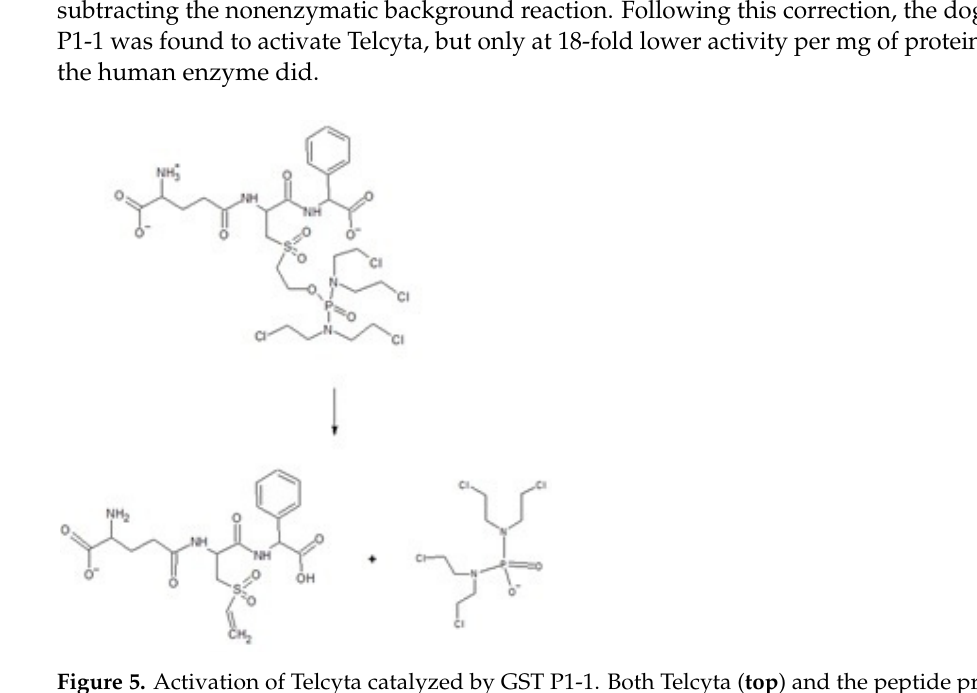
Figure 5. Activation of Telcyta catalyzed by GST P1-1. Both Telcyta ( top ) and the peptide product ( below ) are detectable by ninhydrin staining.